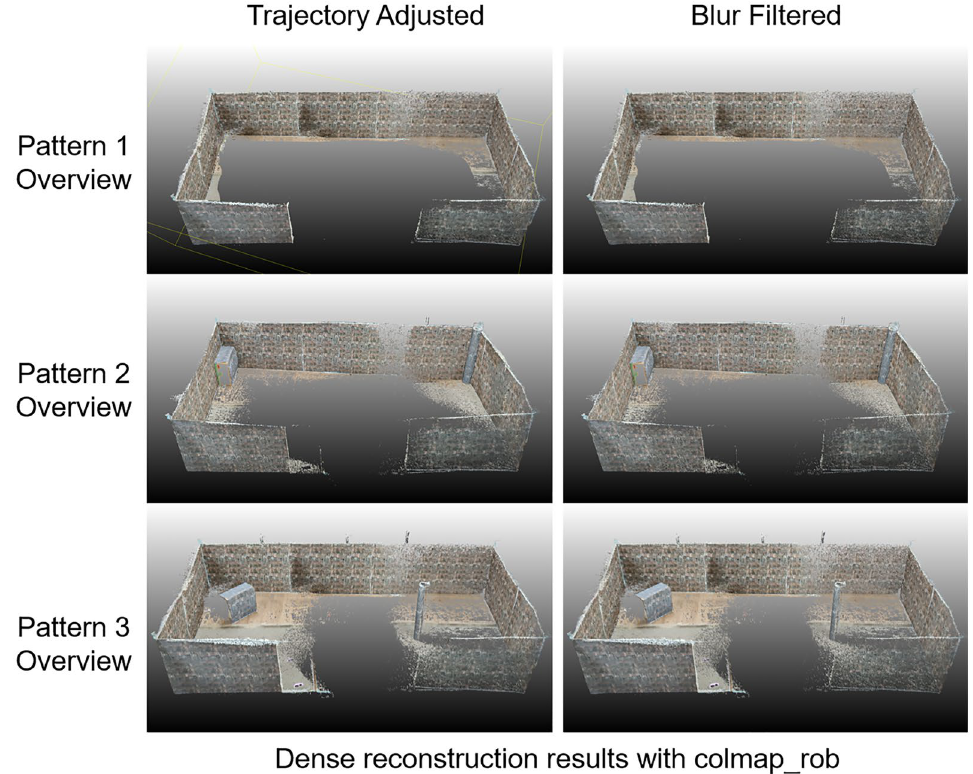
Fig. 14 Reconstruction results by colmap_rob with trajectory adjusted dataset (left) and blur filtered dataset (right) under three setup patterns